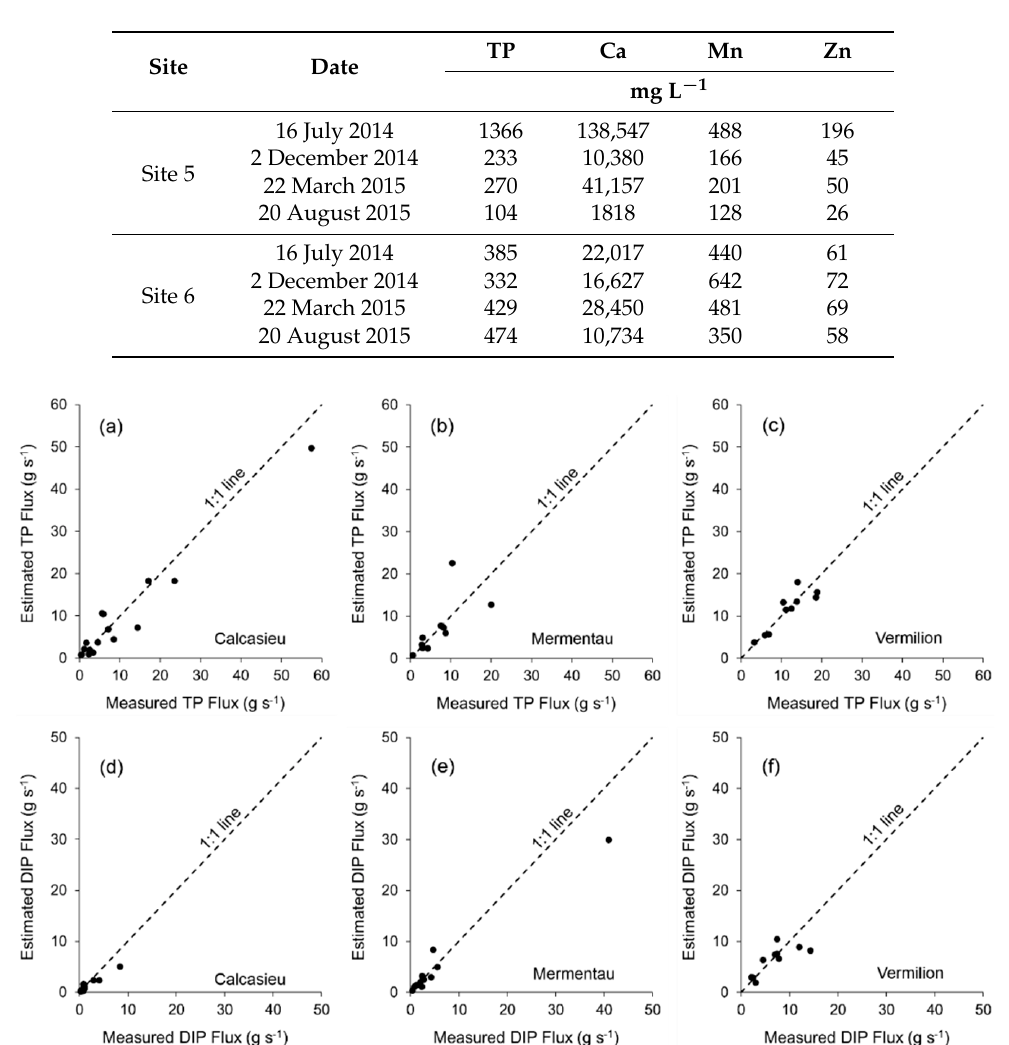
Figure A1. Relationship between measured TP and DIP fluxes and estimated TP and DIP fluxes using regression equations (Equation (1)) for the Calcasieu (Site 1), Mermentau, and Vermilion Rivers from April 2014 to February 2016. ( a ) Relationship between measured and estimated TP flux in the Calcasieu River; ( b ) Relationship between measured and estimated TP flux in the Mermentau River; ( c ) Relationship between measured and estimated TP flux in the Vermilion River; ( d ) Relationship between measured and estimated DIP flux in the Calcasieu River; ( e ) Relationship between measured and estimated DIP flux in the Mermentau River; ( f ) Relationship between measured and estimated DIP flux in the Vermilion